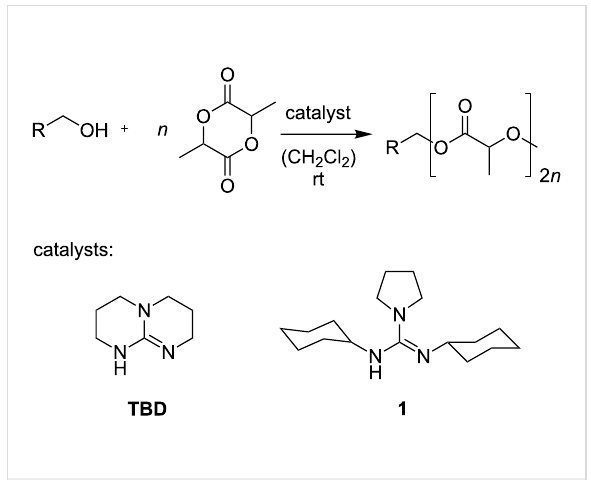
Scheme 1: Ring-opening polymerization (ROP) of lactide with TBD or the acyclic guanidine 1 as catalysts